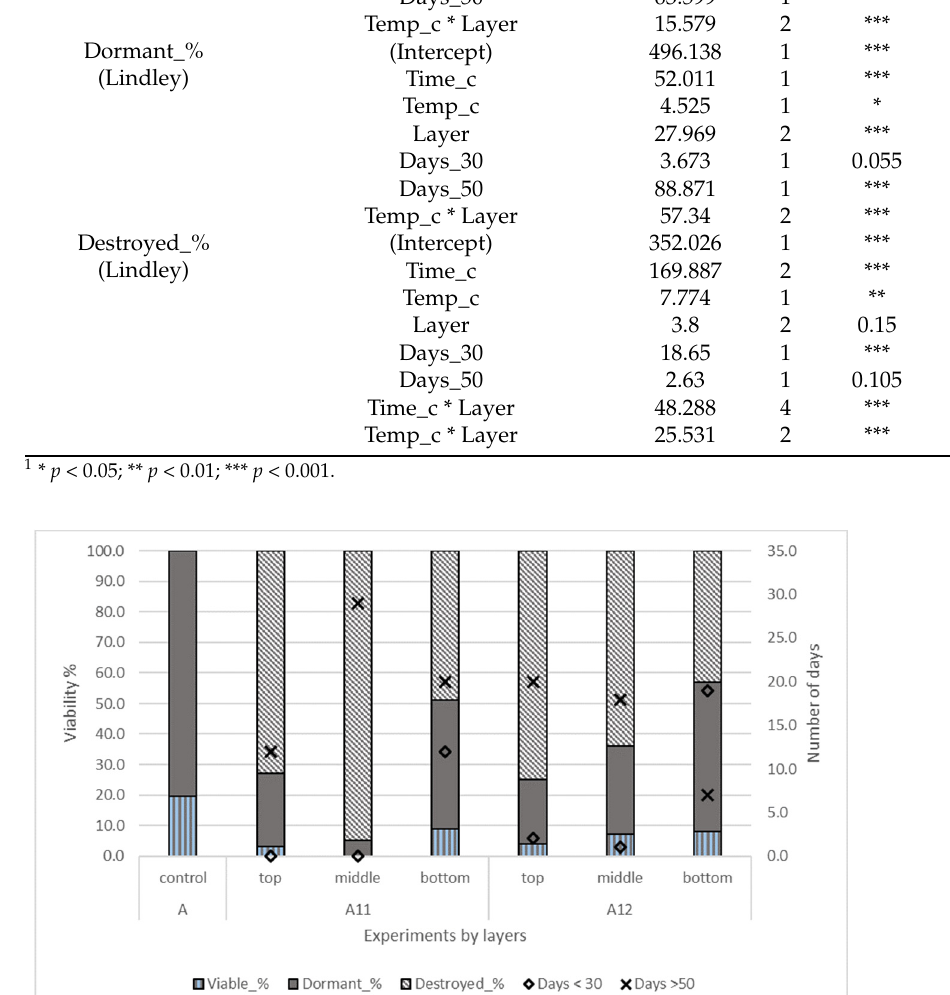
Figure 4. Proportion of viable, dormant and destroyed L. polyphyllus Lind. seed after windrow (A11, A12) and tunnel (T1) composting (bars) showing average temperature classified as mes- ophilic (1) and thermophilic (2). Results from the one-month tunnel composting experiments (T1, N = 965 and T2, N = 1078) were compared to the four-month windrow composting (A2, N = 800) with higher temperatures. Higher temperature and longer treatment time (119 days) lowers survival rate significantly in the windrow composting experiment compared to the 29-day tunnel composting. However, some seeds were able to survive even through the four-month windrow composting (Figure 6) even though the proportion of viable seed decreased from 16.7% to 0.1% and that of the dormant seed from 61.6% to 0.6%. All differences cannot be explained by temperature, as in T2, samples were packed inside polyester bags as in other treatments, capsules excluding static pressure and decreasing the contact with biomass were used. As static pressure (approximately top 324.5 kg / m 2 , middle 973.5 kg / m 2 and bottom 2206.6 kg / m 2 ) was included in samples of T2, even lower temperatures in bottom layer did not raise the proportion of viable (14%) or dormant (49%) seeds. Control samples used in the tunnel experiments had remarkably high proportion of viable seed and control in windrow experiment (A2), the proportion of dormant seed was over 80% (Figure 6A).